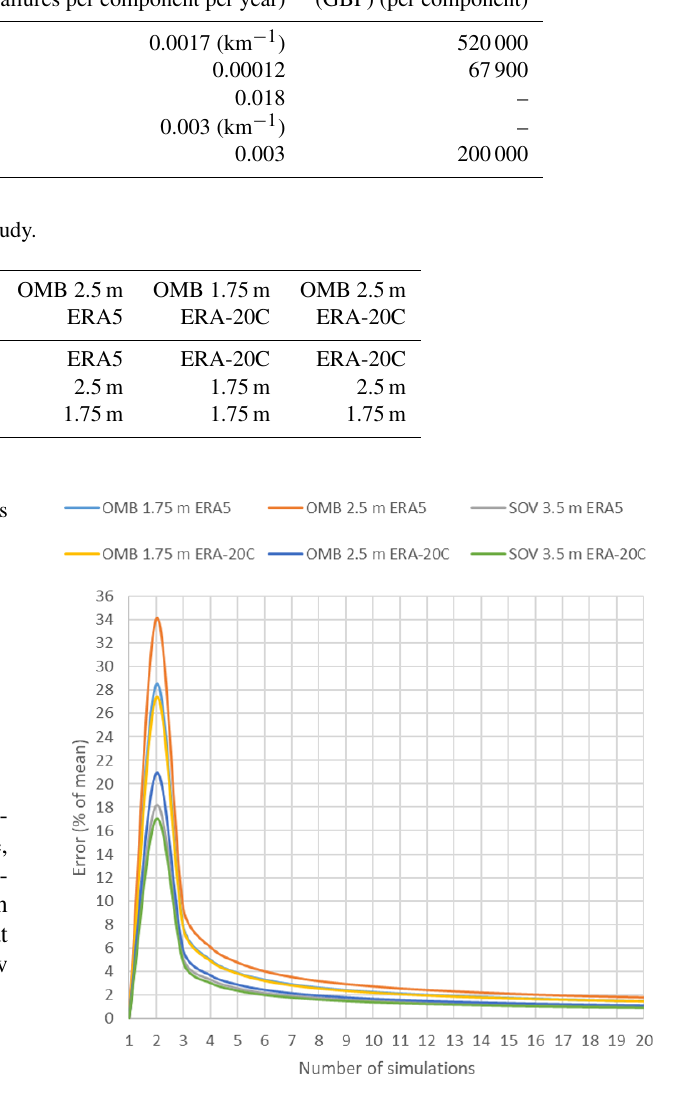
Figure 6. OPEX convergence after running 20 simulations of each